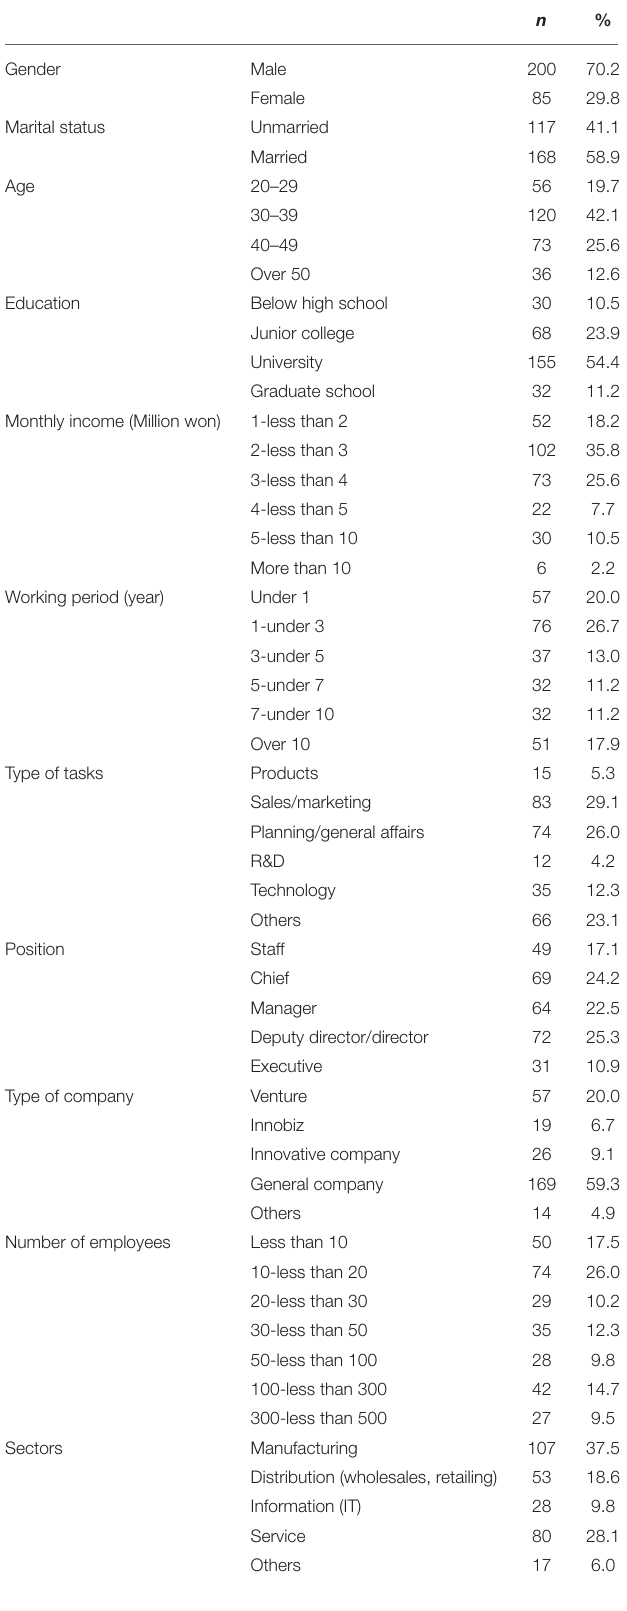
TABLE 1 | Socio-demographic profiles of respondents ( n =